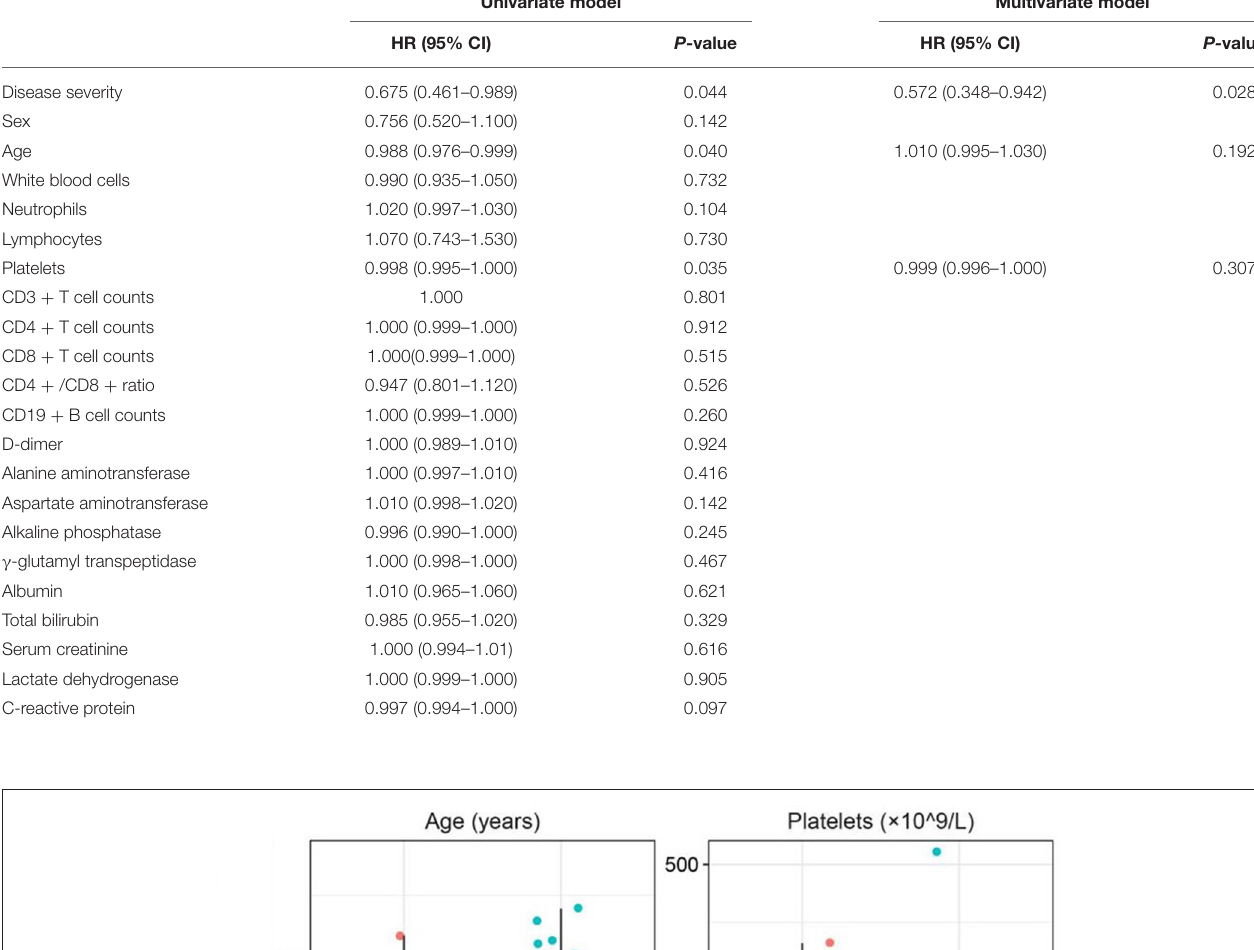
TABLE 2 | Univariate and multivariate cox regression model analysis results of the time from symptom onset to positive nucleic acid test.